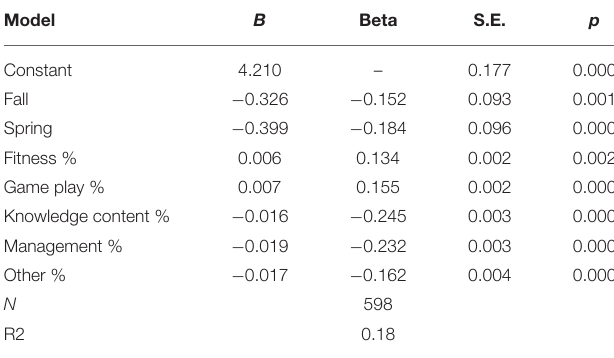
TABLE 6 | Ordinary Least Squares Regression Analysis for